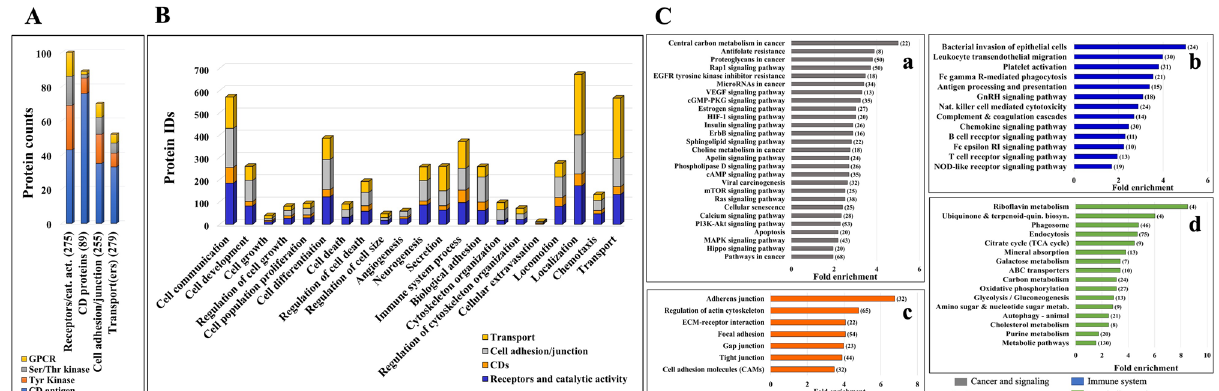
Figure 6. Bar charts of selected functional categories and pathways associated with the detected cell-membrane proteins. ( A ) Categorization of the detected receptors/enzymes, antigens, transporters and cell adhesion/ junction proteins into Tyr kinase, Ser/Thr kinase, GPCR and CD groups. ( B ) Cancer-relevant enriched biological processes represented by the cell-membrane proteins. ( C ) Enriched KEGG pathways represented by cell-membrane proteins involved in: (Ca) signaling and cancer, (Cb) immune response, (Cc) adhesion/junction, and (Cd) metabolism and transport. Notes: Numbers in parentheses represent the number of proteins matched to each process; full lists, fold-enrichment and FDR values are provided in Supplemental file 2; the background gene sets were the full set of corresponding proteins in the human proteome. Examples of cell-membrane or membrane-associated proteins: Growth factor receptors (EGFRs, FGFRs, IGFRs, MET, OGFR), hormone receptors (INSR, IGF1R, ADIPOR1, VIPR), receptor type tyrosine protein phosphatases (PTPRA, PTPRJ), non-receptor Tyr kinases (LYN), Tyr kinase ephrins (EPHAs, EPHBs, EFNAs, EFNBs), plexins (PLXNs), nectins (PVRL1), GPCRs (rhodopsin, secretin, adhesion, frizzled), small GTPases (RHOA, RHOG, HRAS, RAC1, RAB13), proteins with roles in immune response (IL/IFN receptors, chemokine receptors and ligands, HLA class 1 antigens, HMGB1), adaptor proteins (SHC1), integrin receptors (ITGAs, ITGBs, ITGAV), cell–matrix adhesion (focal adhesion integrins, DAG1), cell–cell adhesion (adherens junction cadherins/protocodherins, desmosomal desmocollin/desmoglein/plakins, gap junction connexins, tight junction claudins, occludins, JAMs and ZO proteins), CAMs (EPCAM, BCAM, MCAM, CDH5/CD144, NEO1, mucins), immunoglobulin-like CAMs (ICAM1, L1CAM, ALCAM, nectins), MMPs (MMP15/24), disintegrins (ADAM 9/10), Ca-binding proteins (S100A8/9, PRKCA, spectrins), transport (ABC transporters, SLC carriers), ion channels (ligand/ voltage gated, TRPM cation channels), and cytoskeleton reorganization proteins (ENAH, VASP, MYH10, EZR,